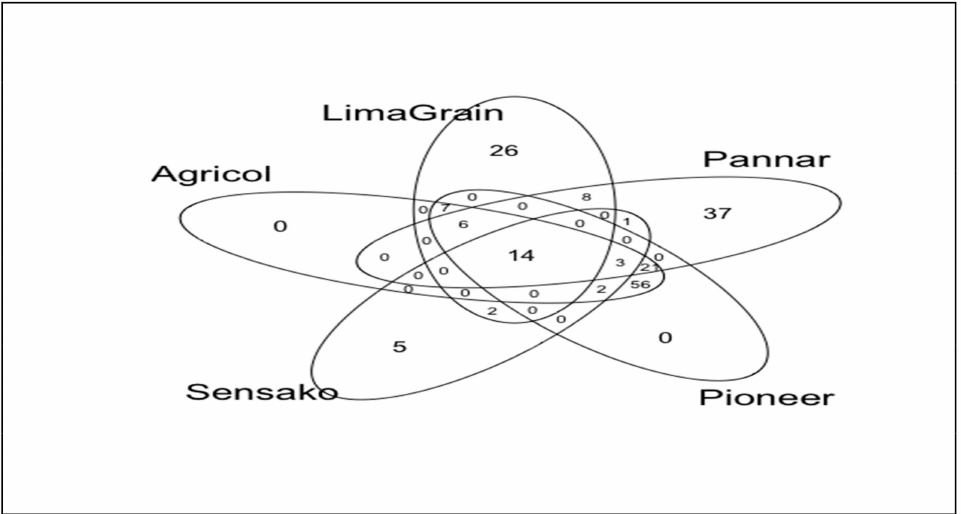
Figure 3. Venn diagram showing the shared and the unique amplicon sequence variants (ASVs) of fungi distribution among the various cultivar